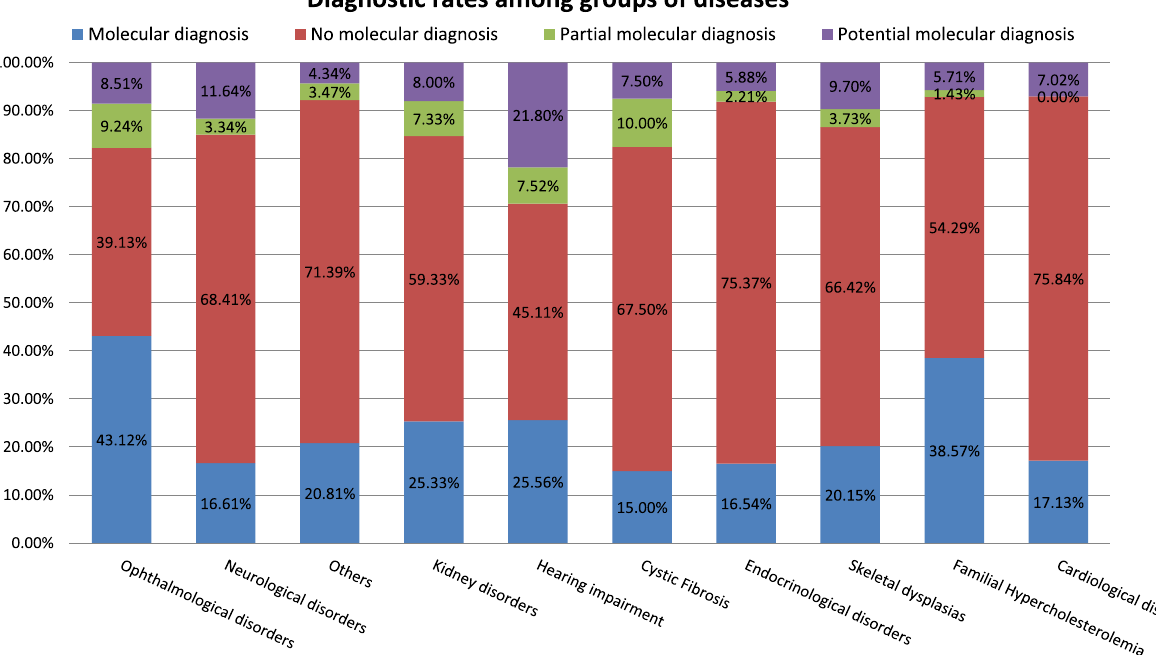
Figure 4. Diagnostic rates among groups of diseases. “Molecular diagnosis”: a P or LP variant in a dominant or X linked gene; as two P or LP, one P and one LP variant in a recessive gene, respectively, sex regardless; “Potential molecular diagnosis”: a VUS in a dominant gene potentially explaining the phenotype, two VUS in a recessive gene potentially explaining the phenotype or VUS in a X-linked gene. “Partial molecular diagnosis”: only one P or LP variant in a recessive gene (monoallelic) potentially explaining the phenotype. “No molecular diagnosis”: no variants or either a monoallelic P, LP or VUS in recessive gene or a VUS in a dominant gene not clearly related with the clinical suspicion were